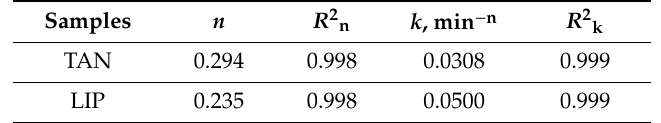
Table 4. Kinetic parameters of the fillers released from investigated samples.